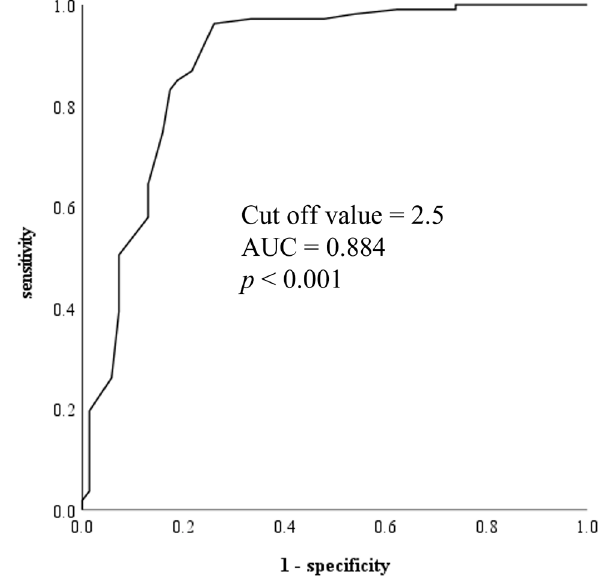
Figure 5. Receiver operating characteristic curve of RAP during inspiration. Abbreviations: AUC, area under the curve; RAP, right arterial